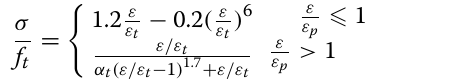
, t where c compression, tensile; d k = σ k ! stress corresponding to strain; E 0 = in aged elastic modulus; ε k = inelastic strain; factor, 0.6 in compression and 0.9 in tension. The uniaxial compression constitutive relation of AAC is